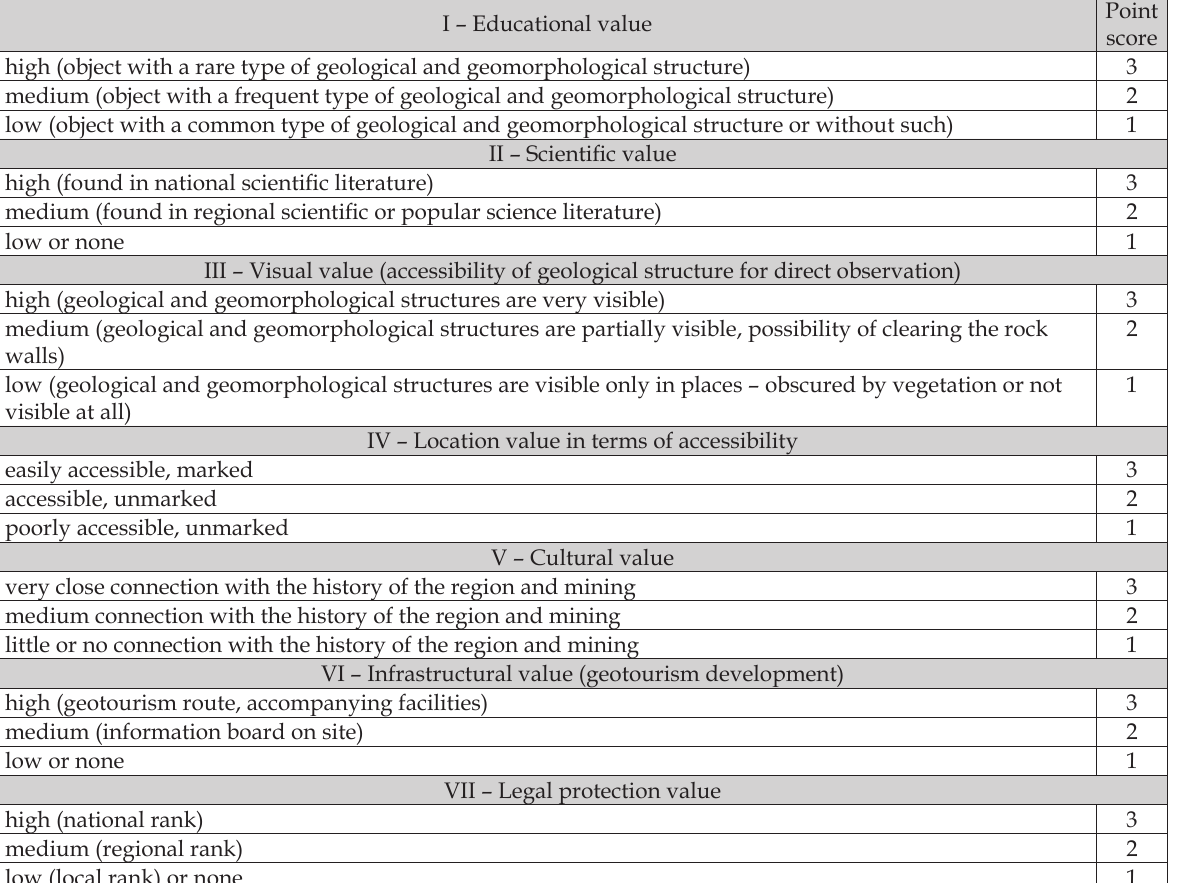
Table 1. Criteria for geotourism valorisation and scoring